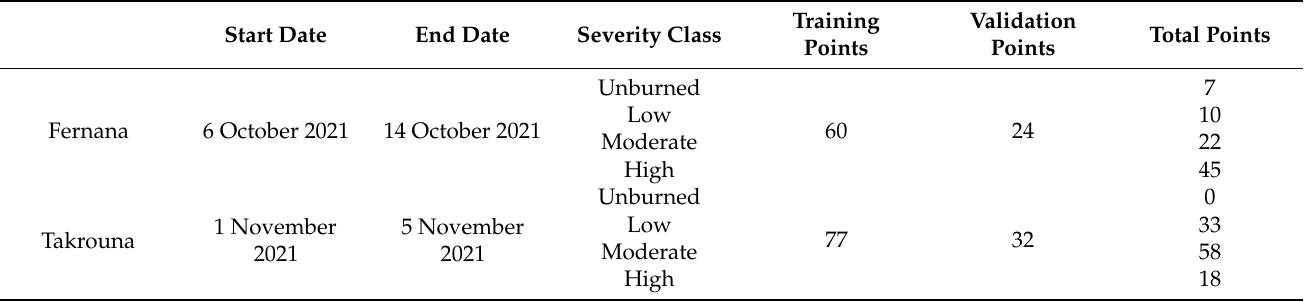
Table 3. Dates and number of the training and validation datasets under different levels of severity in both the Fernana (F1) and Takrouna (F2)